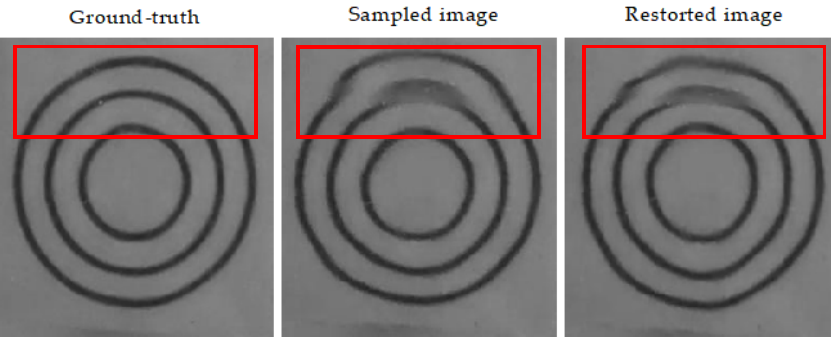
Figure 16. Recovery result of a sampled frame using the proposed method.